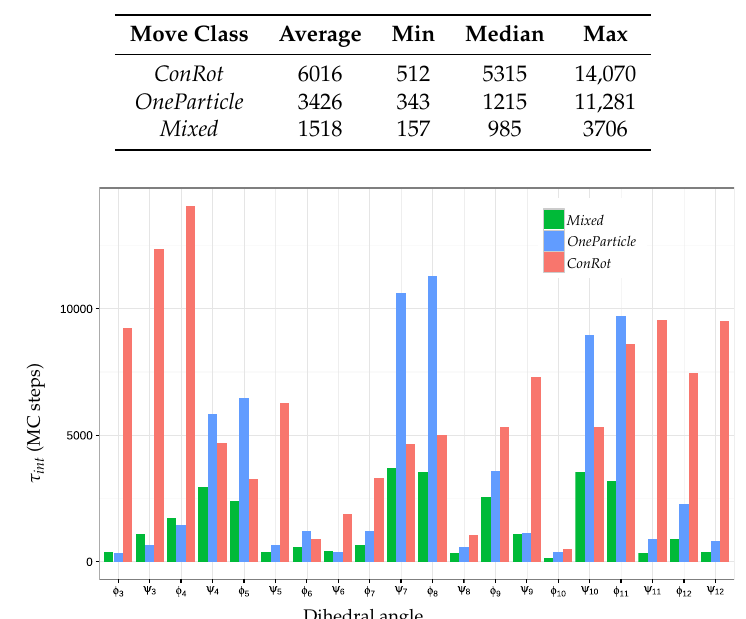
Figure 6. Autocorrelation times τ int (in MC steps) of the 20 central dihedral angles of 14-alanine for the ConRot , OneParticle , and Mixed move classes. Table 3. Autocorrelation times τ int (in MC steps) of the ConRot , OneTorsion , and Mixed move classes